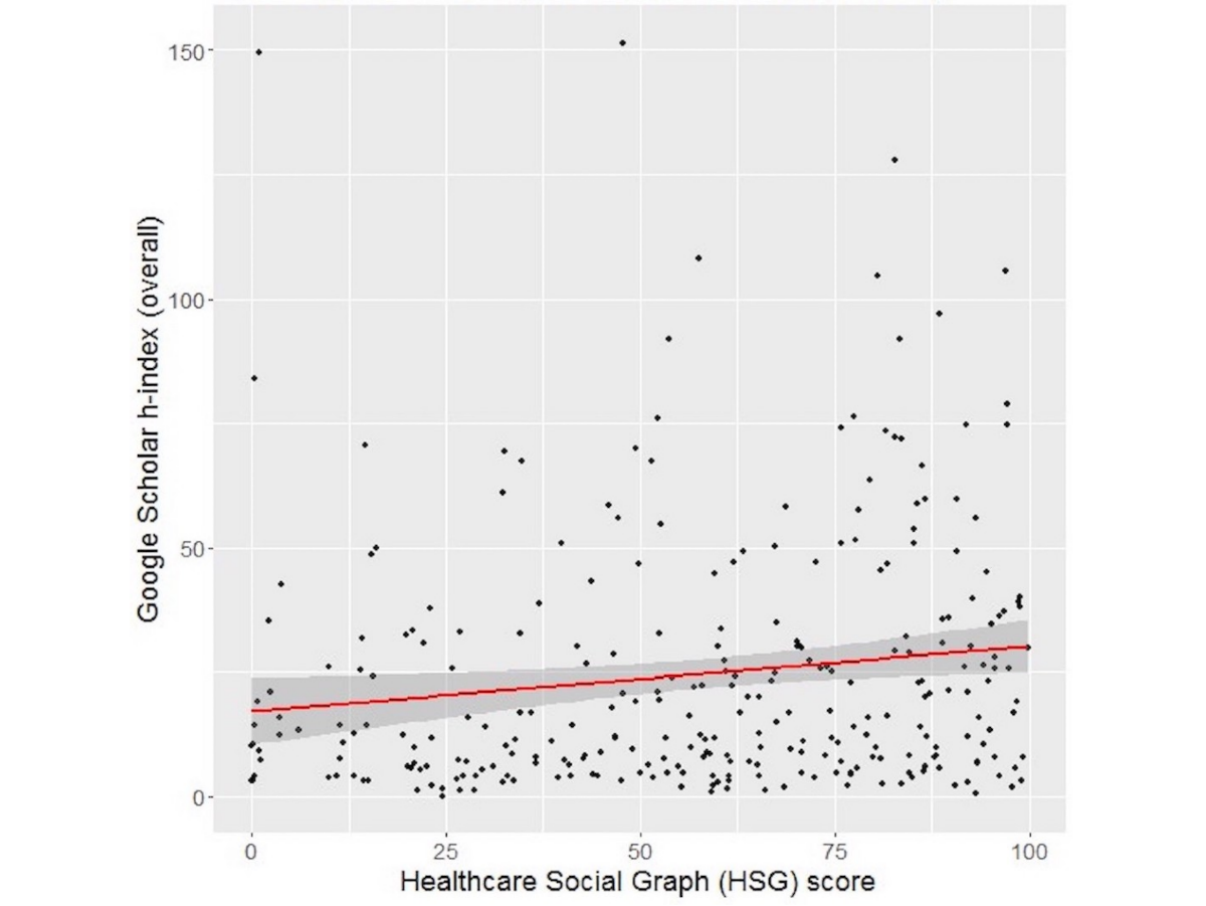
Figure 1. Correlation between HSG scores and Google Scholar overall h-indexes. Spearman correlation coefficient ρ =0.1979 (N=286). The red line is the regression line; the shaded area is the 95%